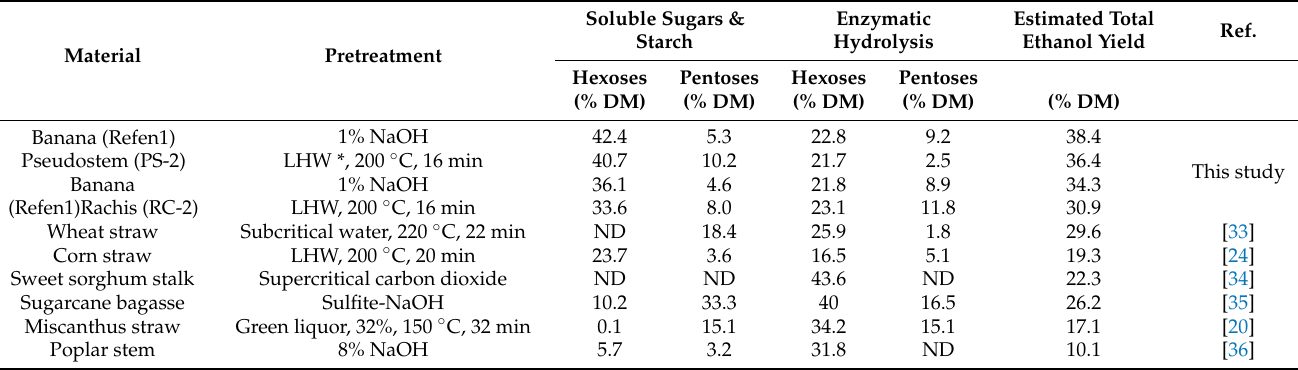
Table 2. Comparison of bioethanol yields achieved in this work and in the previous studies.